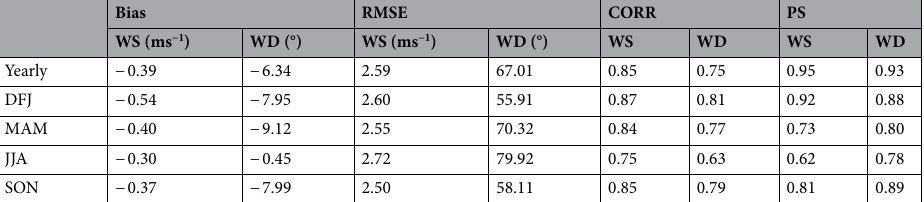
Table 2. Yearly and seasonal mean wind speed and wind direction bias (CCLM – FINO3), root mean square error (RMSE), correlation (CORR), and Perkin’s score (PS) of CCLM compared with FINO3 in the period